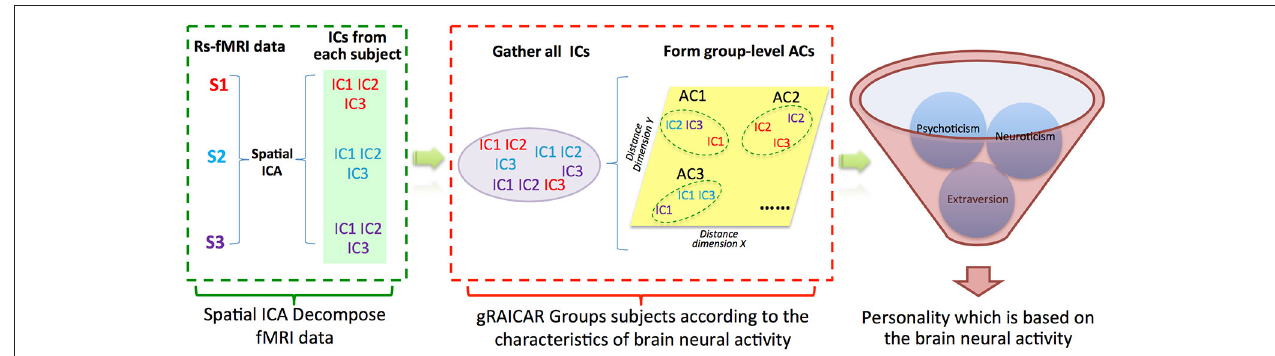
FIGURE 1 | Demonstration of data analysis flow. For simplicity, we assume that there are only three subjects (denoted as S1, S2, and S3). First, the fMRI data of subjects are decomposed individually by using spatial independent component analysis (ICA) into spatial components (ICs). Assume that for each subject we can get three ICs that are color coded to indicate which subject they are from. The resultant ICs maps are presented in the green layer. Second, all of the ICs from individual subjects were pooled in gRAICAR (as presented in the purple layer). We present a distance space depicting the similarity between all ICs in the yellow layer. The intention of gRAICAR in this part is to identify ICs that are from different individuals but are close to each other (as marked with green dashed circles). The group-level aligned components (ACs) were formed by these clustered ICs sequentially, and a community detection algorithm can be applied to each AC to identify homogeneous subject communities among all subjects. Third, we try to seek a kind of personality trait, according to which the subjects could be grouped into communities that maximally agreed with the brain neural activity derived communities.